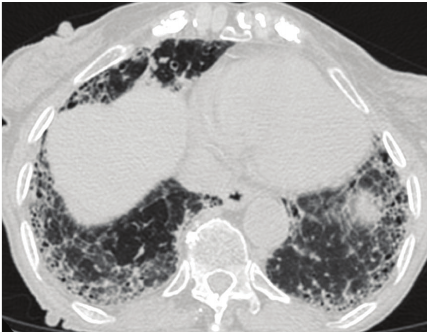
Figure 6: HRCT of the chest at the level of the lower lobes. An extended and coarse subpleural reticular pattern is noted associated with traction bronchiectasis and bronchiolectasis as well as with